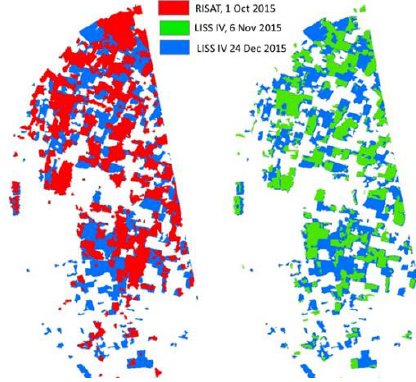
Figure 8. Comparison of banana classified using RISAT and